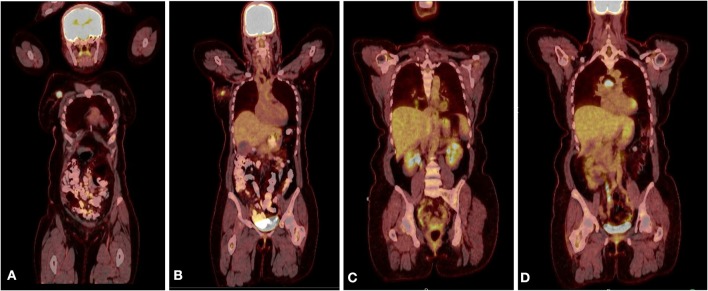
(A) PET CT scan showing the primary lesion in the right upper outer quadrant of the right breast. (B) A hyper metabolic right axillary lymph node, which is compatible with the patient's known right breast primary malignancy and a presumed metastatic right axillary lymph node. (C) PET scan after recurrence showing new lung nodules with FDG uptake. (D) PET scan after recurrence showing sub-carinal lymph node with new intense focus of FDG uptake.